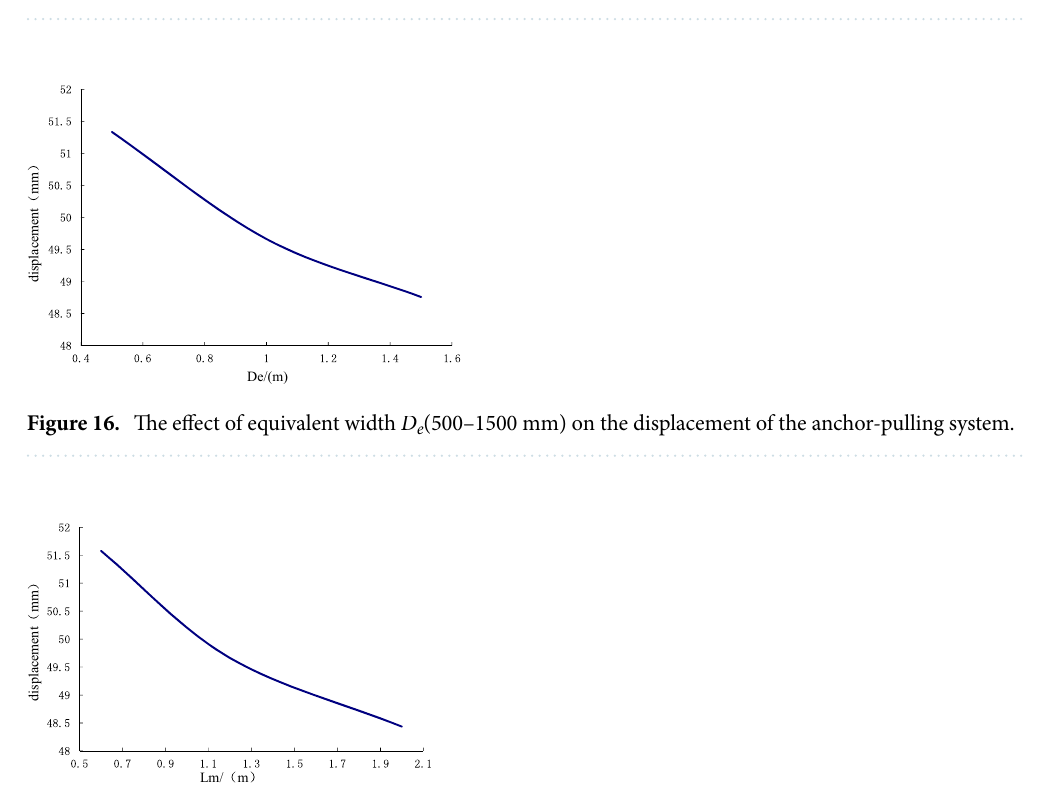
0.26 ) on deformation −